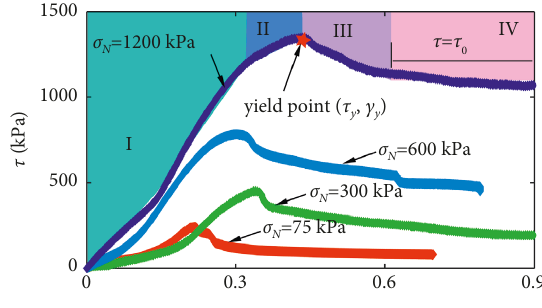
Figure 2: τ - c curves of the TFPU-bentonite contact surface under different σ N s.